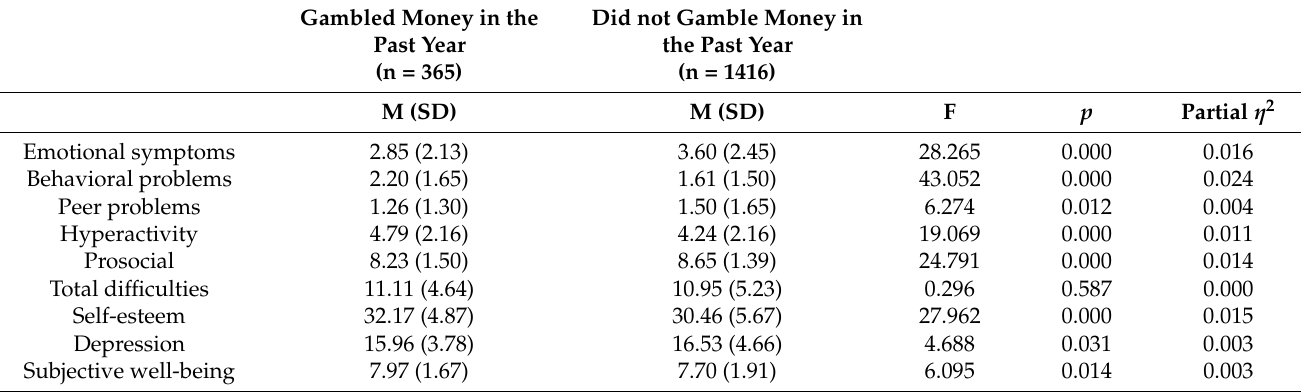
Table 5. Comparisons of mean scores on the variables according to whether they gambled money in the past 12